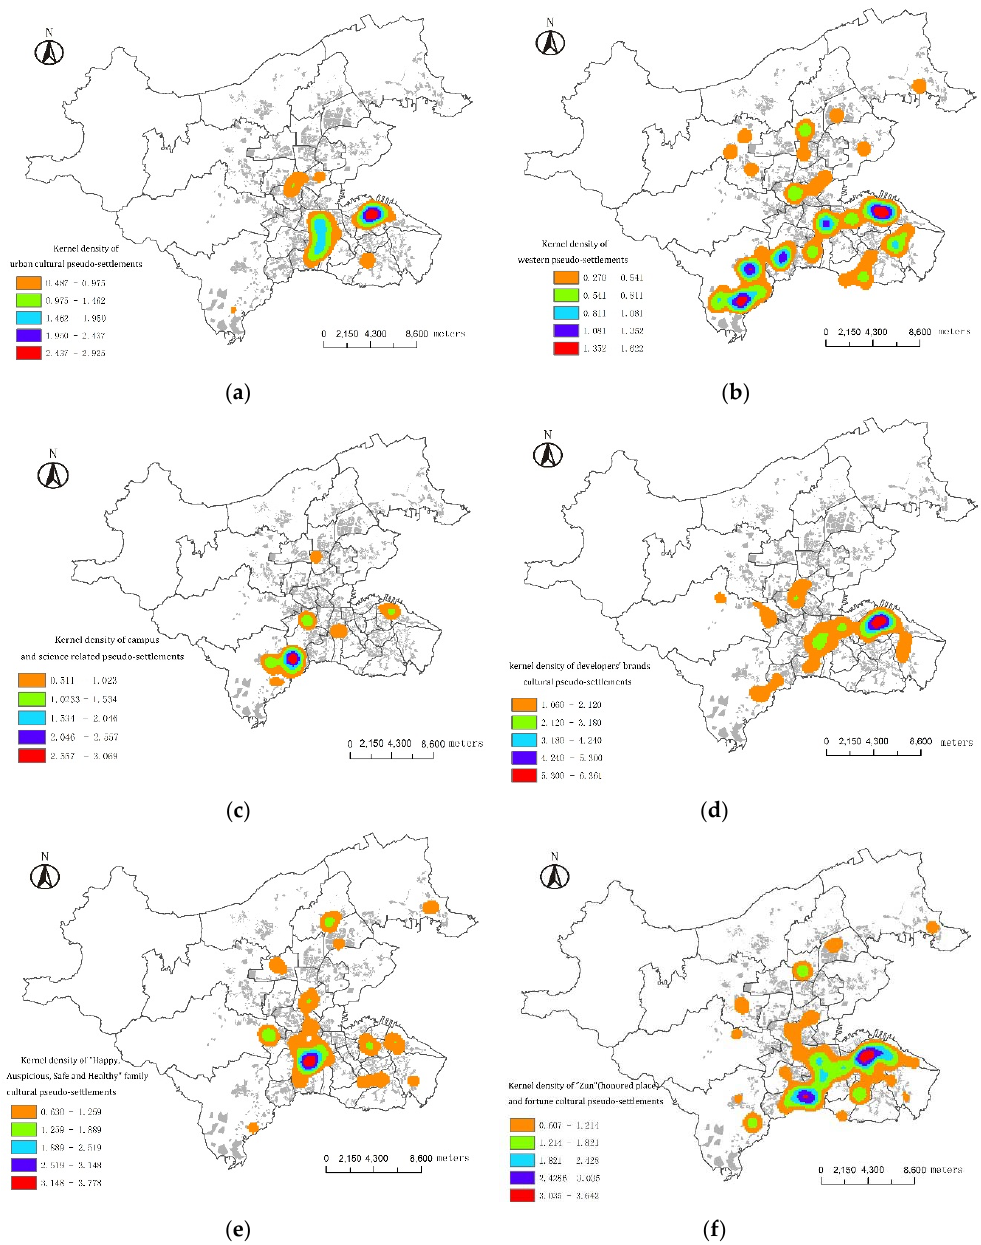
Figure 4. Spatial features of the pseudo ‐ culture of human settlements in Dalian. ( a ) Urban culture ‐ related pseudo ‐ settlement; ( b ) Western culture ‐ related pseudo ‐ settlement; ( c ) Campus technology culture pseudo ‐ settlements; ( d ) Developer brand name ‐ related pseudo ‐ settlements; ( e ) Family ‐ related pseudo ‐ settlements; ( f ) Water, house, “Zun” and fortune ‐ related culture pseudo ‐ settlements.